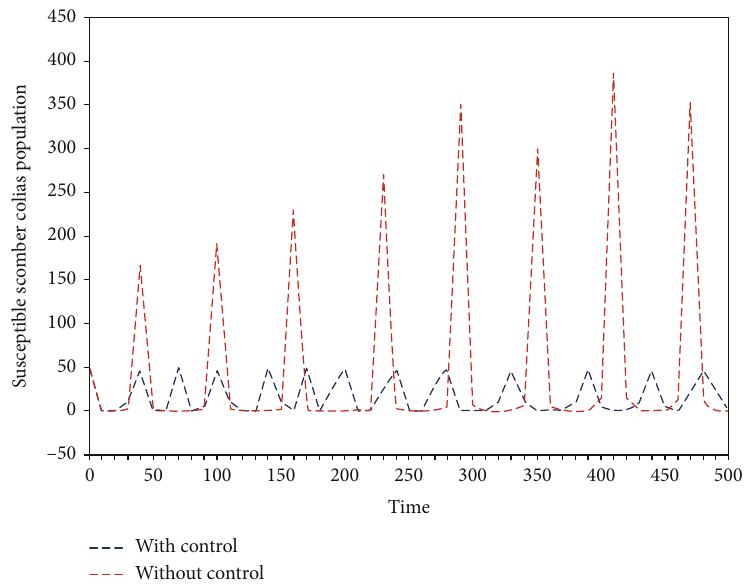
Figure 10: Susceptible Scomber colias population with optimal harvesting and e ff ort harvesting, with medium e ff ort.